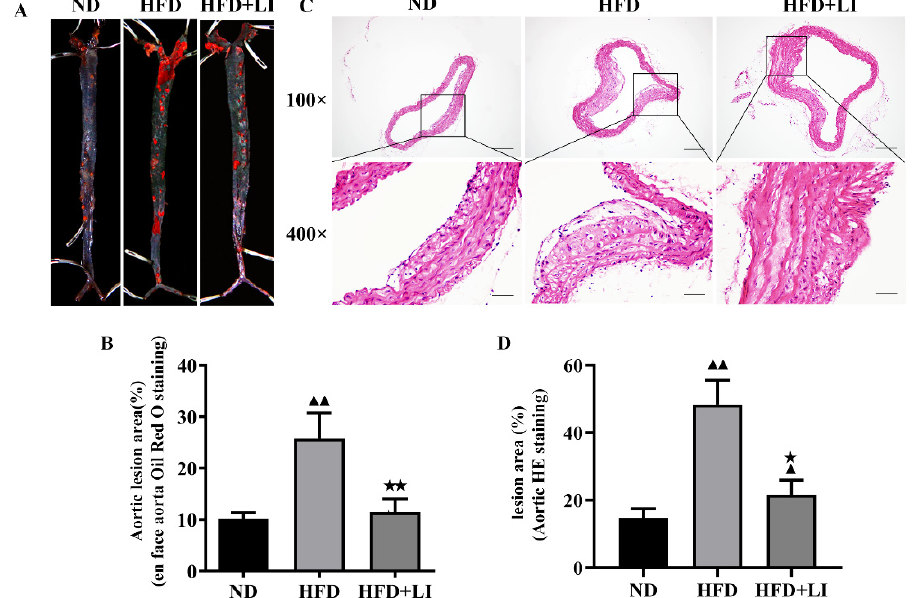
Figure 1. Atherosclerotic lesions in ApoE KO mice according to each diet group. ( A ) Representative images of en face oil red O staining of murine whole aortas. ( B ) Quantitative analysis of A regarding aortic lesion area (%). ( C ) Representative images of H&E staining of murine aortic atherosclerotic plaques at 100× and 400× magnification. ( D ) Relative quantification of ( B ). ▲▲ p < 0.01 vs. ND; ★ p < 0.05 vs. HFD; < 0.01 vs. HFD. Scale bar for 100 × = 200 µ m; scale bar for 400 × = 50 µ